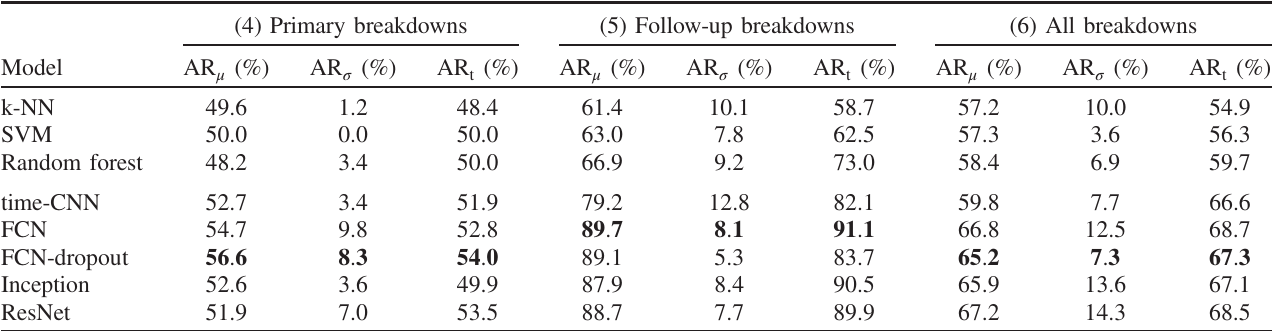
TABLE III. AR score of different models, predicting primary, follow-up, and all breakdowns with event data. The model for each column is highlighted in bold. AR μ relates to the average AR score of different validation sets and AR σ to the standard deviation. The trained model is finally tested on the test set with a performance AR t